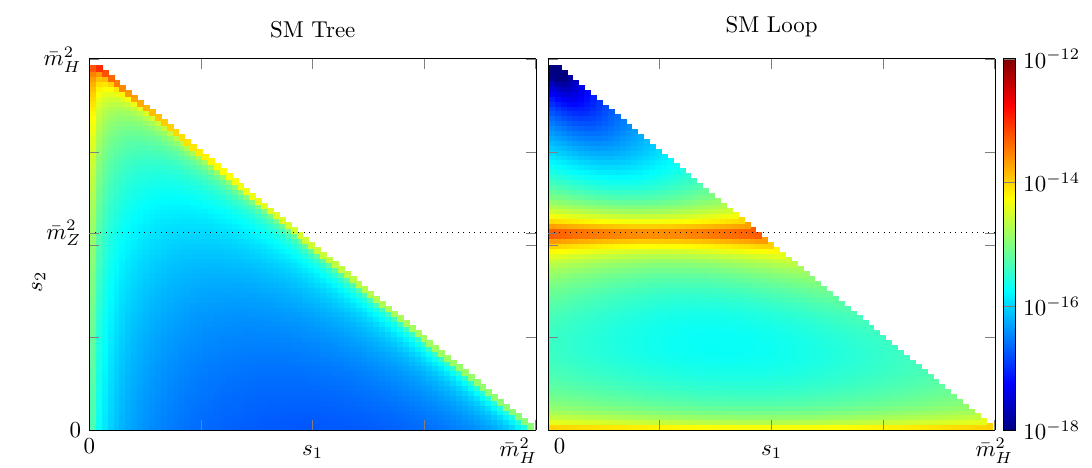
Figure 4: Dalitz plots comparing the tree (Left) and one-loop (Right) contributions to the process H → ¯ µµγ in the SM. The dotted line shows where s mass of the di-muon system, crosses the Z -pole. Units are [ GeV ] − 3 . Cuts on the angle between the photon and two leptons are not included in these Dalitz